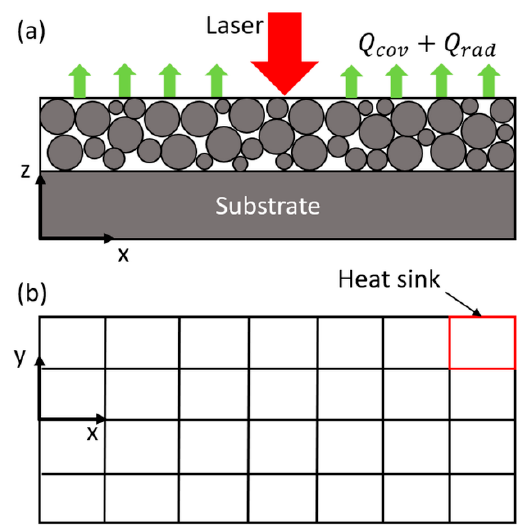
Figure 1. ( a ) Schematic drawing of the heat transfer mechanism in PBMAM. The red arrow represents heat input from the laser moving along positive x-direction. The green arrows represent the heat loss due to convection and radiation from the upper boundary of the powder layer. ( b ) The upper boundary of the powder layer is mathematically discretized into multiple sections (red box) due to the non-uniform temperatures and non-uniform heat loss at the boundary [34].